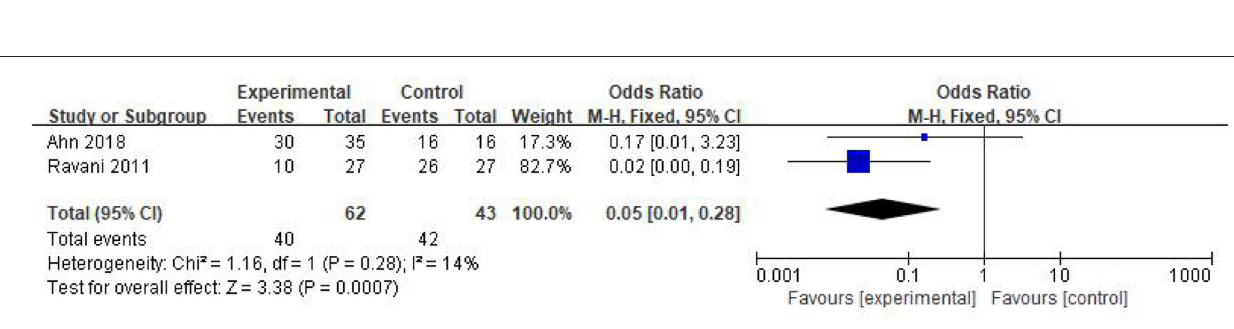
FIGURE 3 | Forest plot showing a meta-analysis for the RTX group vs. control group on the relapse numbers.